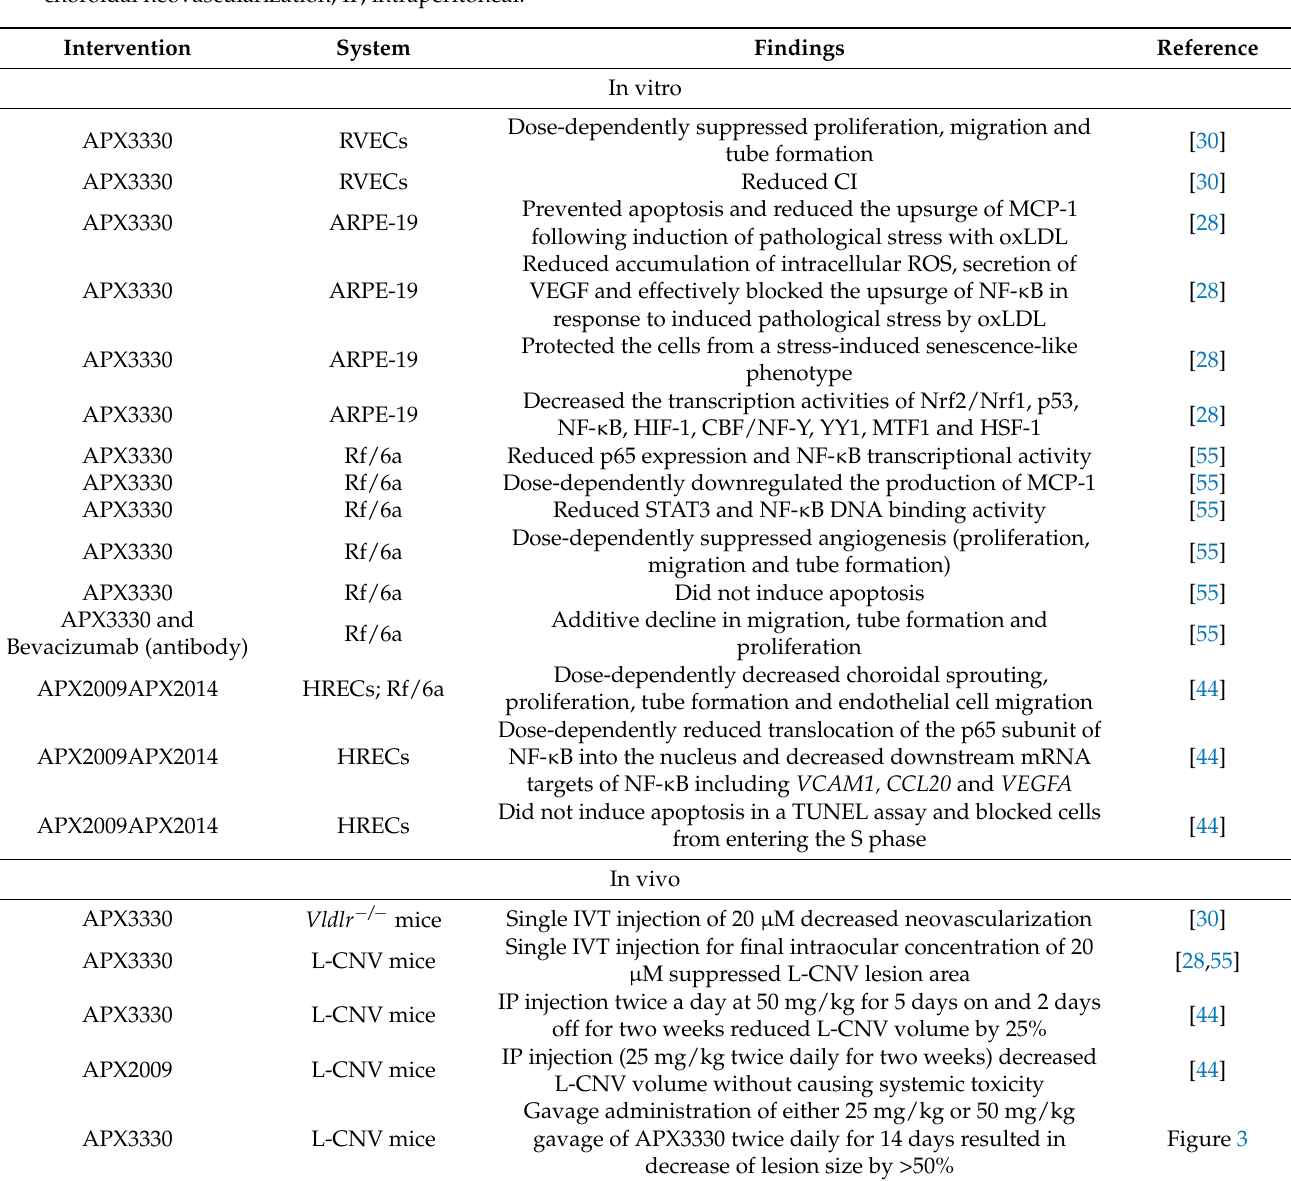
Table 1. Evidence linking APE1/Ref-1 inhibitors with eye disease. Redox inhibitors APX3330, APX2009 and APX2014 have been assessed in multiple systems. For structures of compounds mentioned, refer to Figure 1. Abbreviations: RVECs, retinal vascular endothelial cells; ARPE-19, adult retinal pigment epithelium-19 cell line; CI, cell index; MCP-1, monocyte chemoattractant protein-1; oxLDL, oxidized low density lipoprotein; ROS, reactive oxygen species; VEGF, vascular endothelial growth factor; NF- κ B, Nuclear factor κ light-chain-enhancer of activated B cells; Nrf2/Nrf1, Nuclear factor erythroid 2-related factor 2 and 1; HIF-1, hypoxia-inducible factor 1; CBF/NF-Y, CCAAT-binding factor; YY1, Ying yang-1; MTF1, metal regulatory transcription factor 1; HSF-1, heat shock factor 1; Rf-6a, macaque choroidal endothelial cell-like cell line; STAT3, signal transducer and activator of transcription 3; HRECs, human retinal microvascular endothelial cells; VCAM1 , vascular cell adhesion molecule 1; CCL20 , C-C motif chemokine ligand 20; VEGFA , vascular endothelial growth factor A; TUNEL, Terminal deoxynucleotidyl transferase dUTP nick end labeling; IVT, intravitreal; L-CNV, laser-induced choroidal neovascularization; IP,